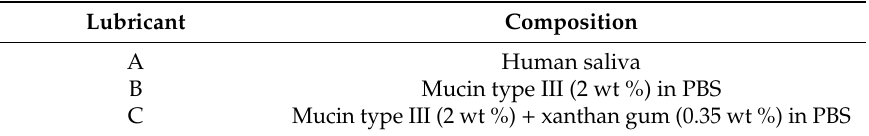
Table 2. Saliva and its substitutes. PBS: phosphate-buffered saline.